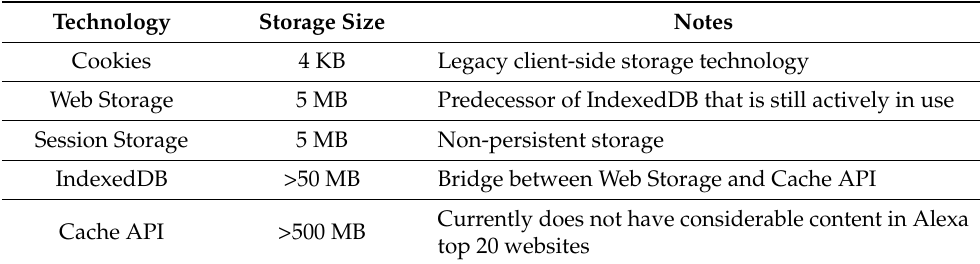
Table 1. Client-Side Technologies and Storage